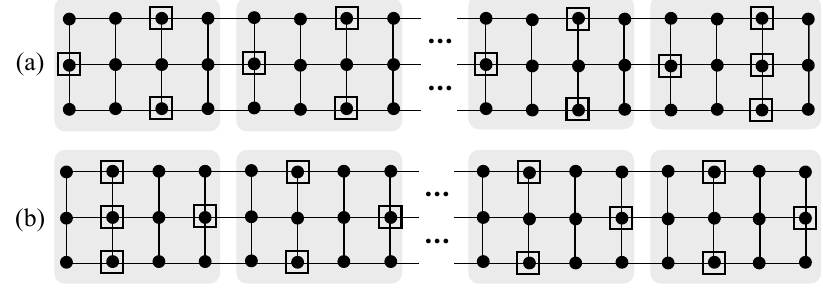
Figure 5: A total switch on the 3